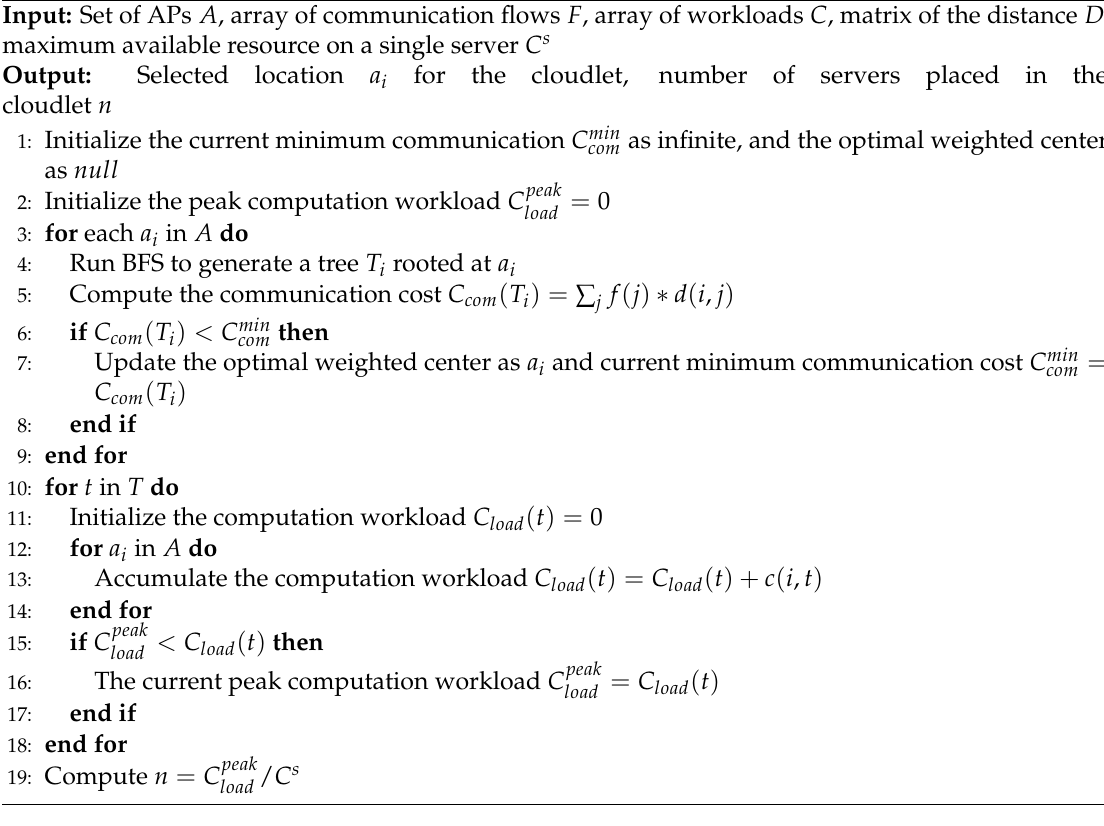
Algorithm 4 Cloudlet Capacity Decision Algorithm